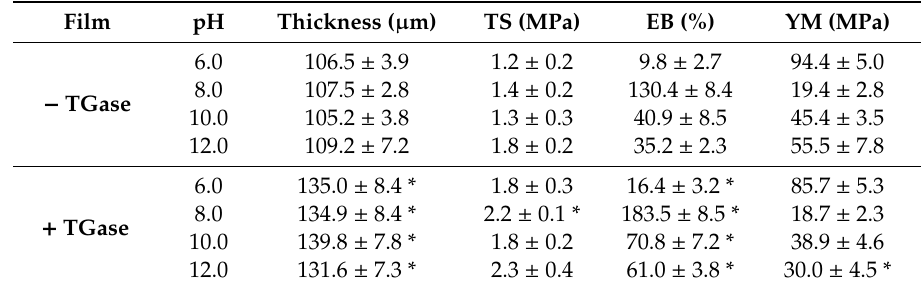
Figure 5. E ff ect of di ff erent concentrations of glycerol (GLY) on the mechanical properties (TS, tensile strength; EB, elongation at break; YM, Young’s modulus) of protein concentrate (PC, 400 mg) films obtained at pH 8.0 after incubation of FFSs in the absence or presence of transglutaminase (TGase, 20 U / g protein). Further experimental details are given in the text. * Significantly di ff erent values as compared to those obtained under the same experimental conditions in the absence of TGase ( p < 0.05). Table 1. Mechanical properties (TS, tensile strength; EB, elongation at break; YM, Young’s modulus) of 20% glycerol (GLY)-containing protein concentrate (PC, 400 mg) films obtained at di ff erent pH values after film forming solution (FFS) incubation in the absence or presence of transglutaminase (TGase, 20 U / g protein). Further experimental details are given in the